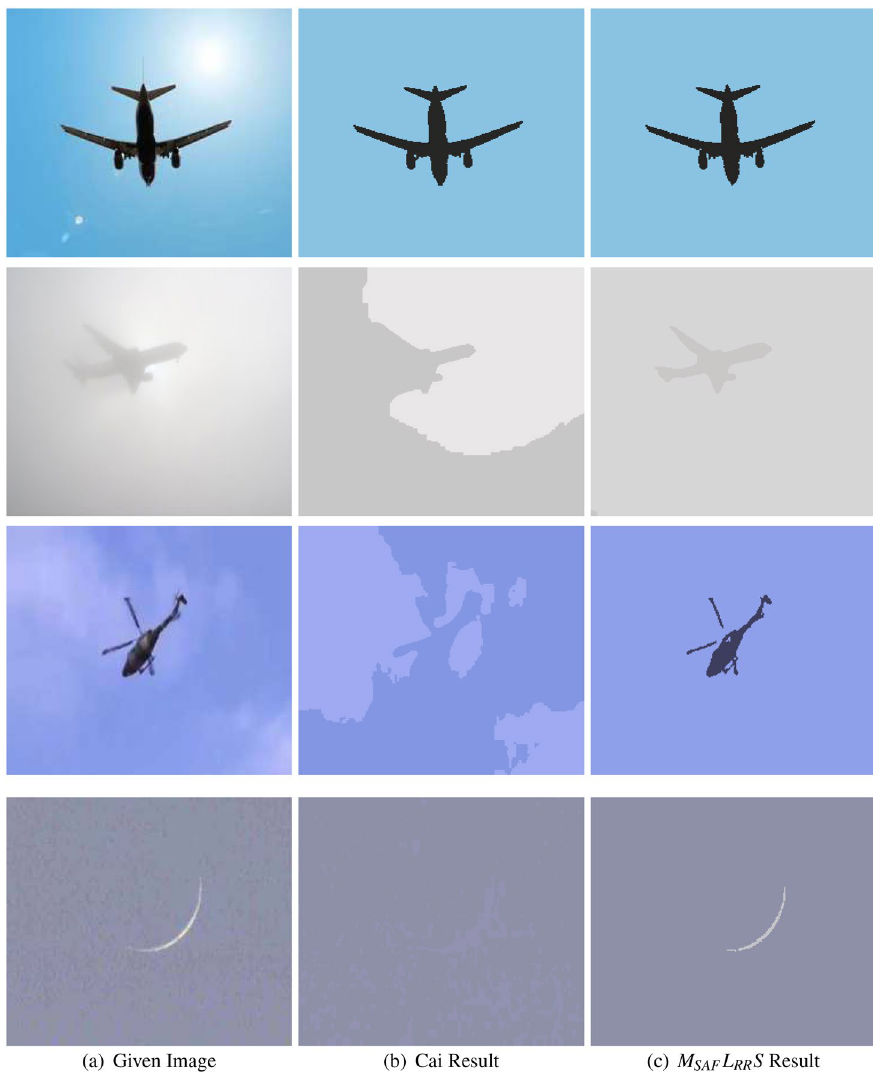
row image (cid:31) 2 = 500 , k = 10 , third row (cid:31) 2 = 100 , k = 30 and the last row image (cid:31) 2 = 500 , k = 30 . These images were taken from the kaggle datasets 33 and are available